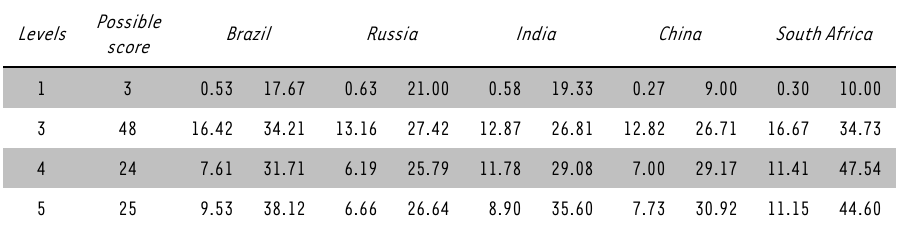
TABLE 6: Element 4 - Performance management and accountability Possible Levels